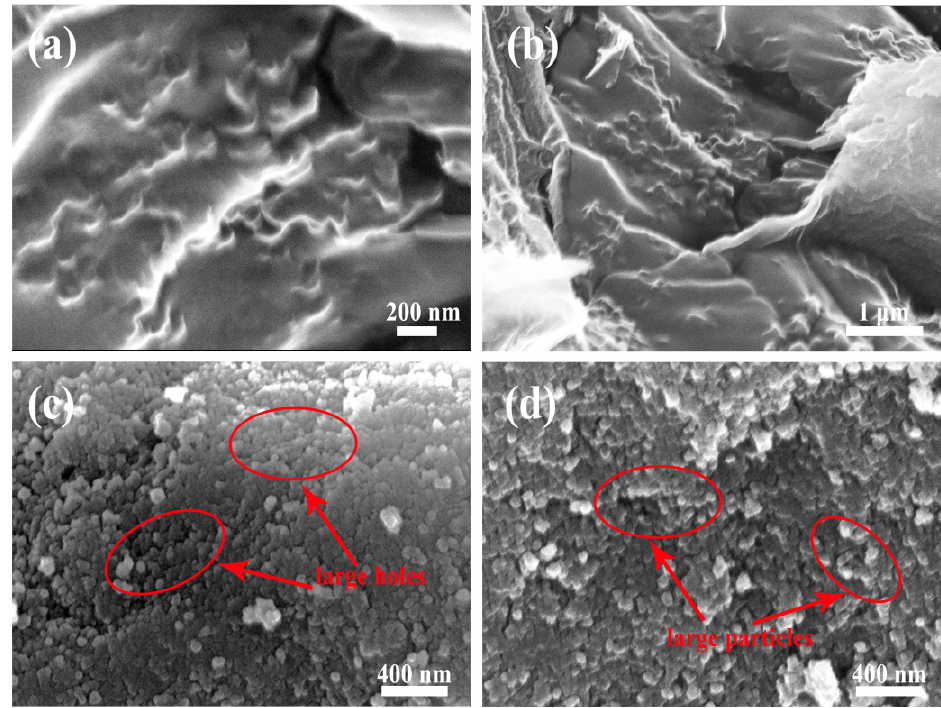
Figure 2. The SEM images of WAA films before ( a , b ) and after ( c , d ) nano-SiO 2 modification.